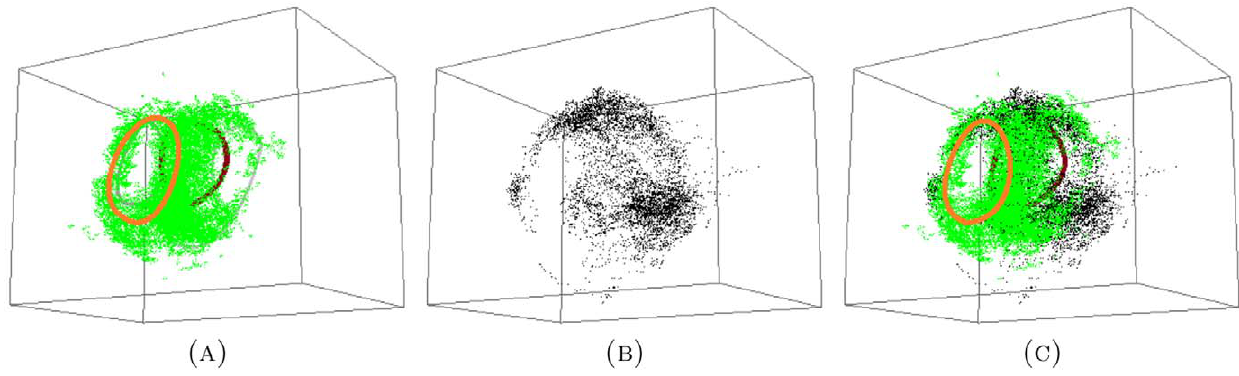
Figure 8. The experimental data for (A) long; (B) distal; and the combined (C) long + distal set. There are four persistent generators for the long set, two of which are consistent between long and long + distal sets (orange and crimson). Grey generators in the long set are not persistent in the combined set. We did not compute the generators for distal set since the data is much sparser than that of the long set.